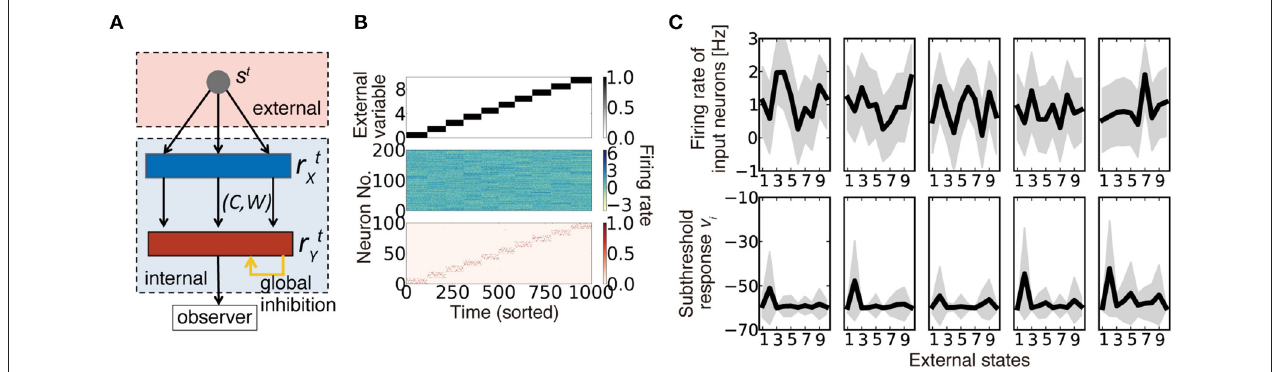
FIGURE 1 | Description of the model. (A) Schematic diagram of the model. (B) An example of model behavior calculated at ρ 0.16, when the synaptic = connection is organized using the weight-coding scheme. The top panel represents the external variable, which takes an integer 0 to 9 in the simulation. The middle panel is the response of input neurons, and the bottom panel shows the activity of output neurons. In the simulation, each external state was randomly presented, but here the trials are sorted in ascending order. (C) Examples of neural activity in a simulation. Graphs on the top row represent the average firing rates of five randomly sampled input neurons for given external states (black lines) and their standard deviation (gray shadows). The bottom graphs are subthreshold responses of output neurons that represent the external state s 1 . Because the boundary condition for the membrane parameter v i = ≡